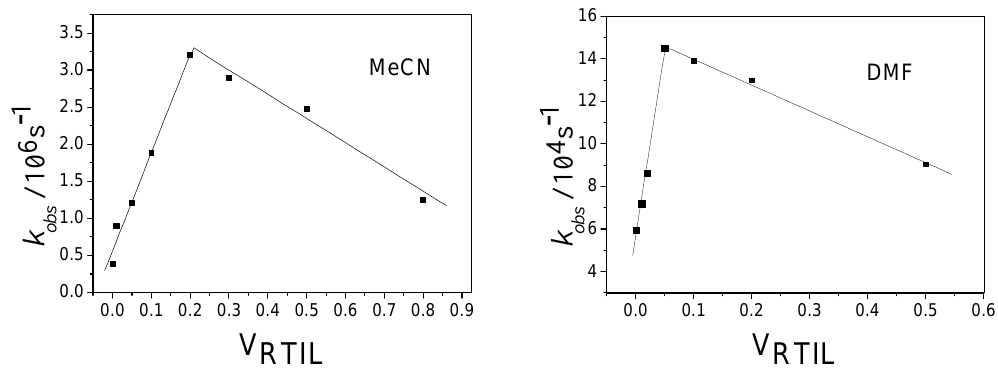
Figure 4. Dependences of 3 AQ* (370 nm) and -• AQ (540 nm) decay rate constants k fraction of RTIL inRTIL/MeCN and RTIL/DMF mixed solutions,respectively.